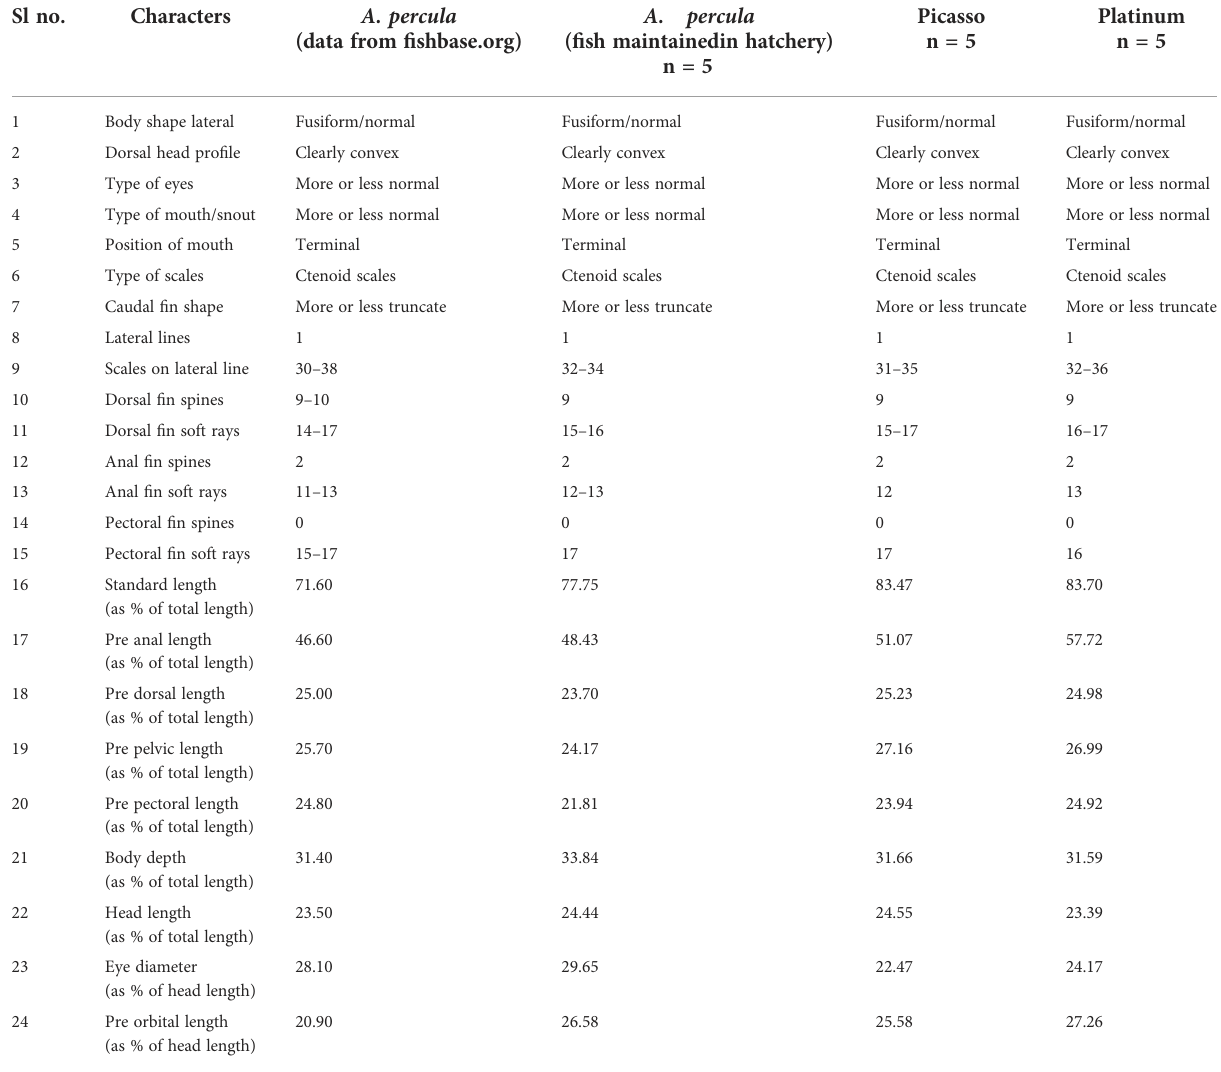
TABLE 2 Morphometric and meristic characteristics of designer clown fi shes (Picasso and Platinum) and Amphiprion percula . Sl